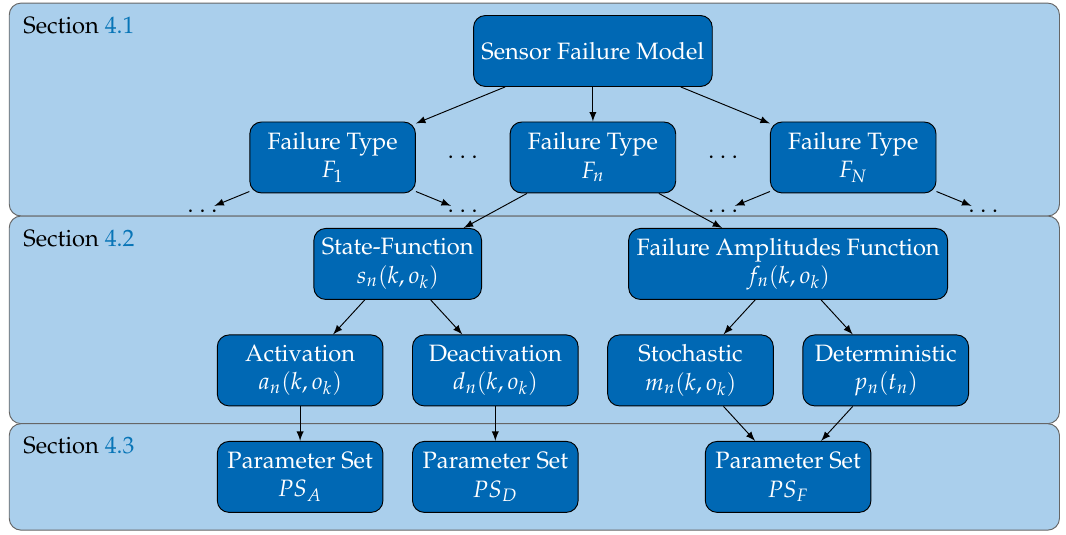
Figure 4. Hierarchical overview on the generic failure